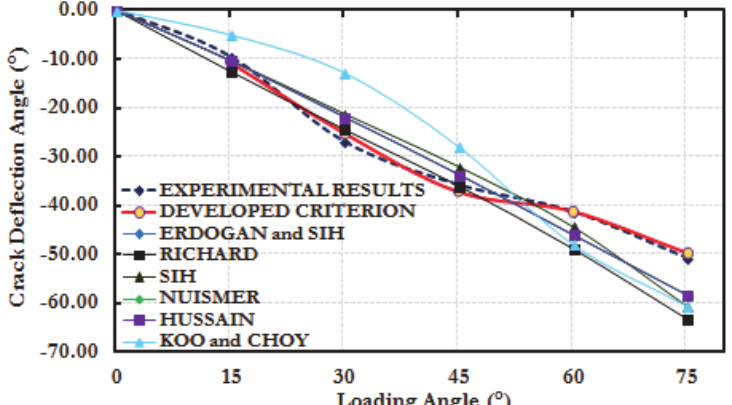
Figure 3: Comparisons of experimental and predicted crack deflection angles - CTS